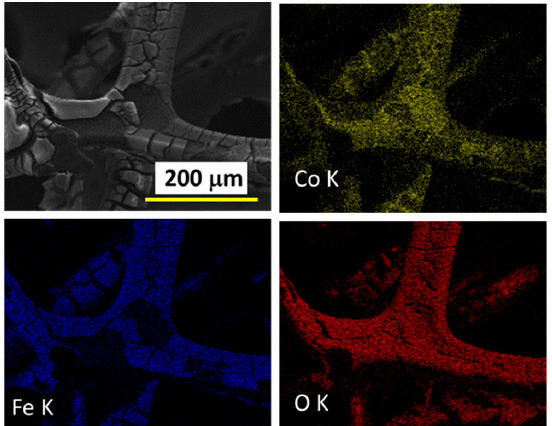
Co, Fe, and Figure 3. EDX elemental maps of electrodeposited CoFe 2 O 4 on Ni-foam revealing the distribution of Co, Fe, and O.